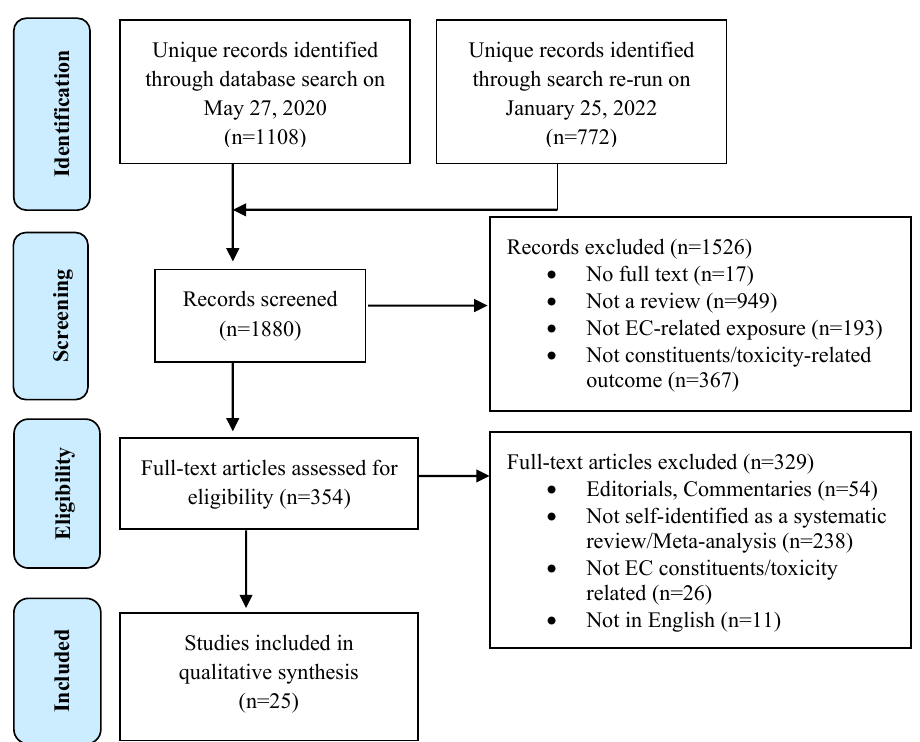
Figure 1. PRISMA flow diagram of the study selection process for the umbrella review.